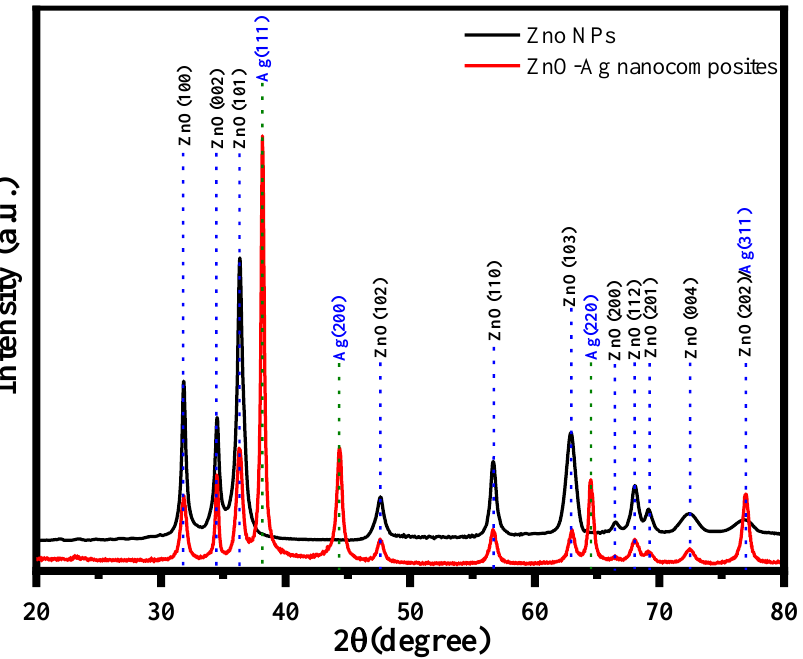
Figure 6. XRD patterns of ZnO NPs and ZnO–Ag nanocomposite. The structural parameters of ZnO NPs and ZnO–Ag nanocomposites calculated from XRD patterns are presented in Table 1. Table 1. X-ray diffraction parameters of ZnO NPs and ZnO–Ag nanocomposite. ZnO